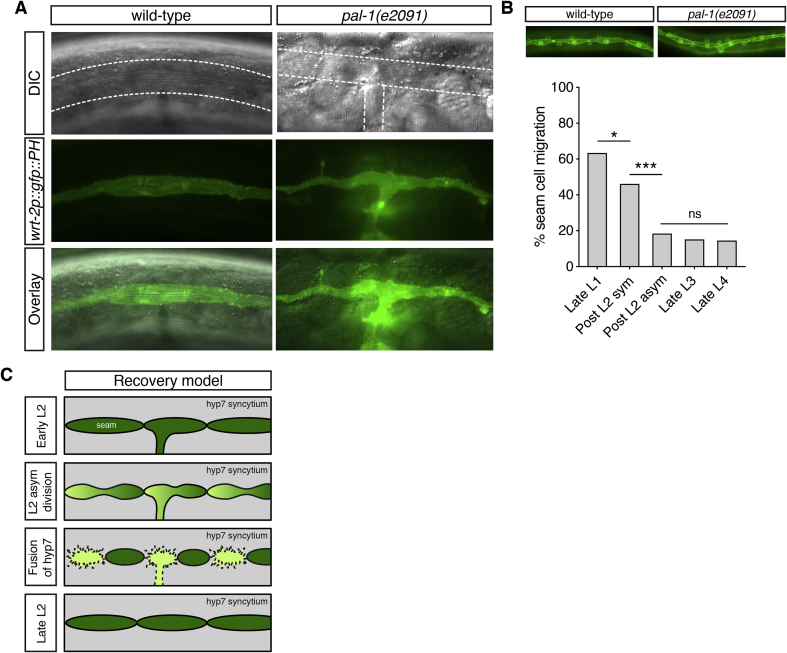
Seam ventral branching in pal-1(e2091) adults causes abnormal alae, although seam morphology is often recovered during larval development.A. Alae and seam branching phenotypes in pal-1(e2091) adults. 6% of animals at this stage (n ​= ​188) exhibit abnormal extensions of alae to the ventral midline in the mid region of the animal (alae highlighted between the dotted white lines), in each case corresponding to the shape of the underlying seam syncytium (GFP). B. Quantification of seam cell migration at each larval stage from late L1 to late L4. The two timings during the L2 molt make reference to the two seam divisions at that stage. Following L1, the seam cell branching phenotype drops in frequency within the population, with the greatest decrease observed following the L2 asymmetric seam cell division (‘Post L2 asym’) [n ​> ​50 per stage; *P ​< ​0.05, ***P ​< ​0.001, two-tailed Student’s t-test]. Seam branching is never observed in wild-type animals at any stage (data not shown). C. Model to explain the seam cell morphology recovery after an asymmetric seam cell division. As the branched seam cell divides asymmetrically, the ventral branch may be inherited by the anterior, differentiating seam daughter. Upon fusion to the hyp7, the abnormal branch of the seam line is lost. The hyp7 is shown in grey, the seam cells in dark green and seam daughters destined to differentiate to hyp7 are light green. Solid black lines indicate apical junctions, whereas a dotted black line shows membranes undergoing cell fusion. At these later larval stages, differentiating hyp7 daughters possess a ruffled membrane as they extend filopodia into the surrounding hyp7, thus migrating either dorsally or ventrally out of the seam line.